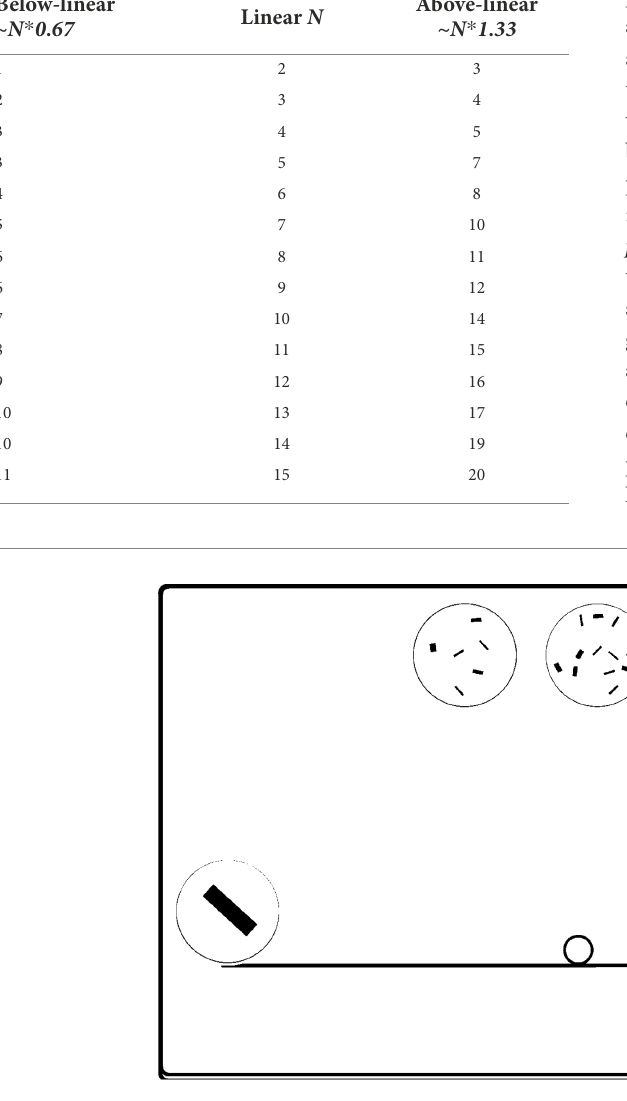
FIGURE 4 Experiment 3: Position-to-number procedure: Sample layout of the screen for the 6–9 – 12 test triplet. A small circle (“plate”) on the line indicates the position for which the appropriate set should be selected out of three options at the top of the